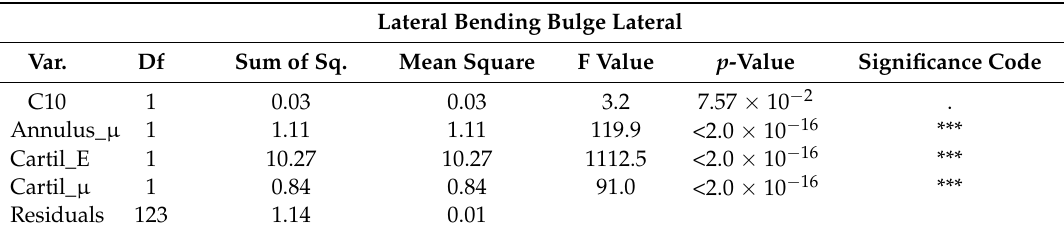
Table 19. ANOVA table for a lateral bending bulge lateral linear model.